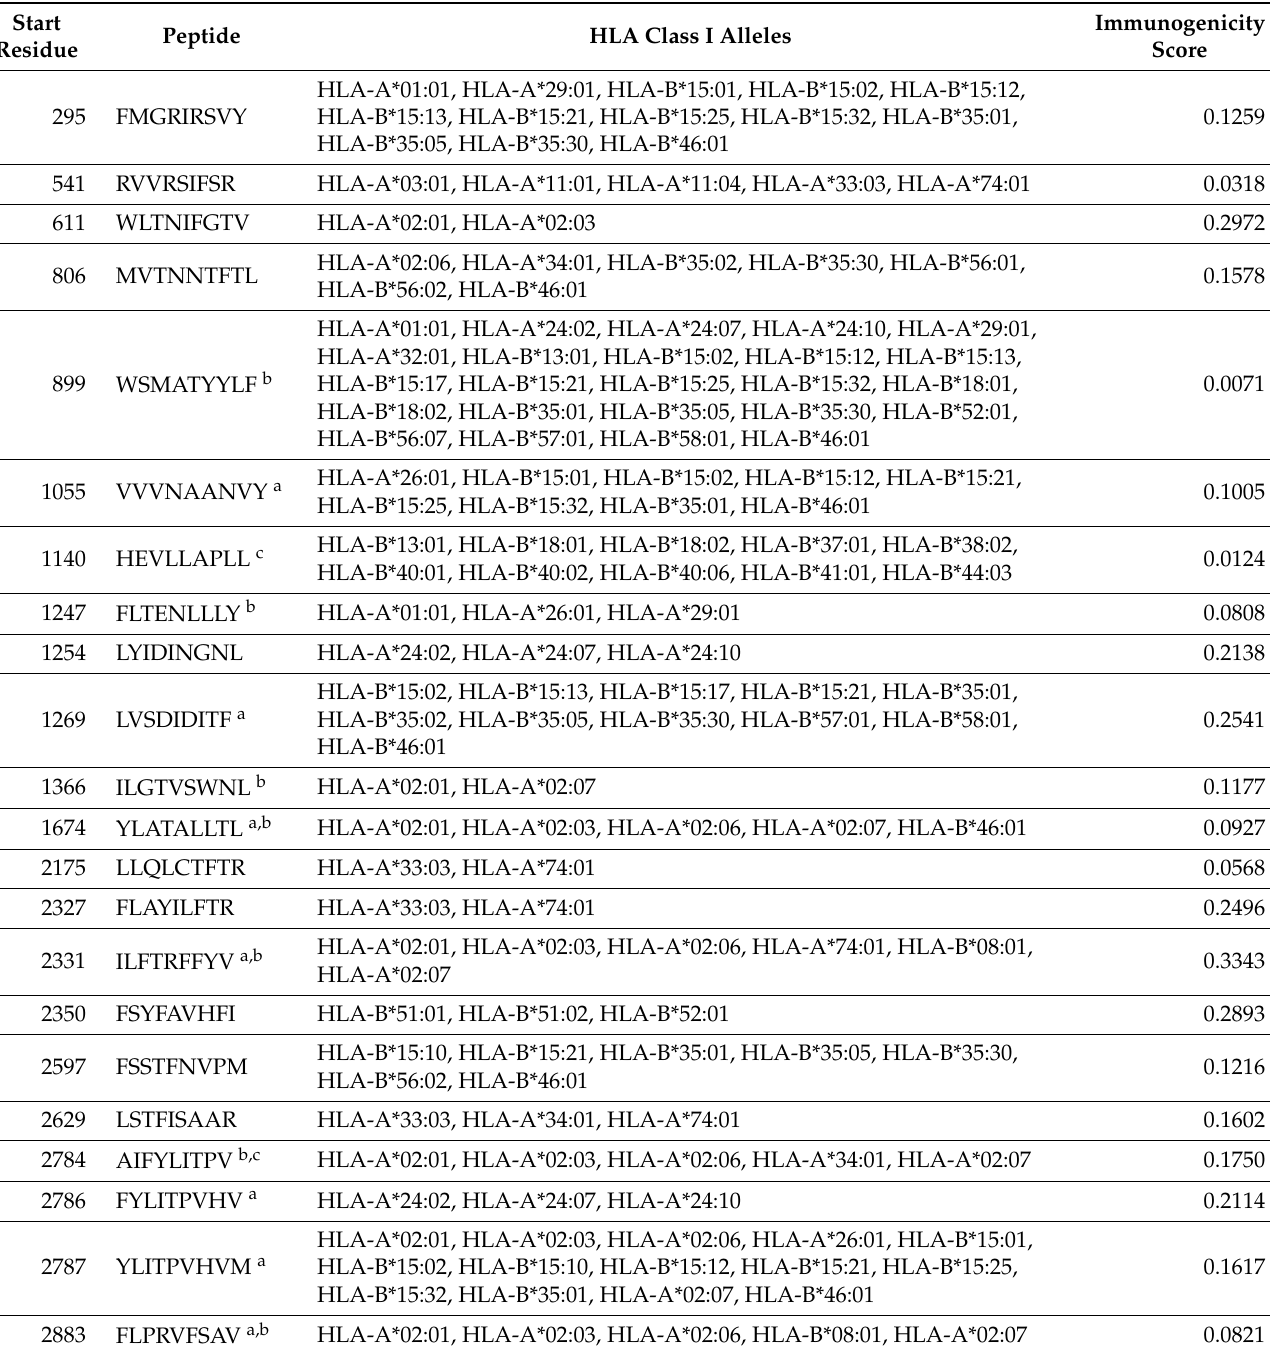
Table 4. List of 9-mer peptides from ORF1ab predicted as promiscuous CTL